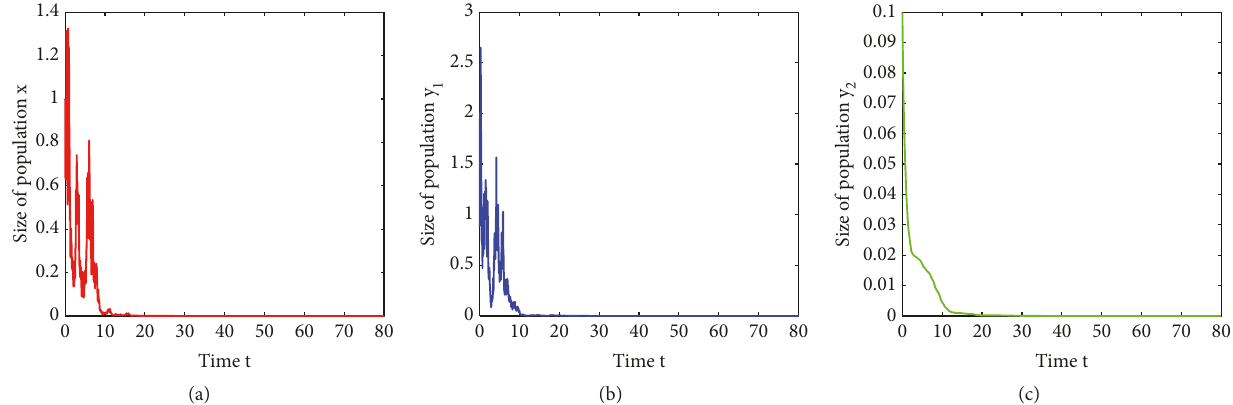
Figure 1: Numerical simulation of the solution of model (6). The parameters of model (6) are 𝑎 = 0.3 , 𝑏 = 0.15 , 𝑐 = 0.2 , 𝜂 = 0.2 , 𝑑 = 0.3 , ̂𝑒 = 0.15 , 𝑓 = 0.5 , 𝛿 = 0.1 , 𝑔 = 0.5 , 𝜎 2